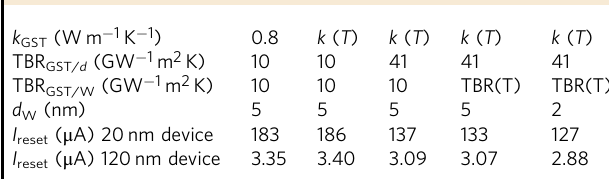
Table 1 The impact of parameters such as thermal conductivity ( k GST ), thermal boundary resistance between GST and dielectric (TBR GST/ d ) or GST and tungsten (TBR GST/W ), tungsten electrode thickness ( d W ) extracted from the empirical measurements on the reset current ( I reset ) for devices with lateral size of 20 and 120